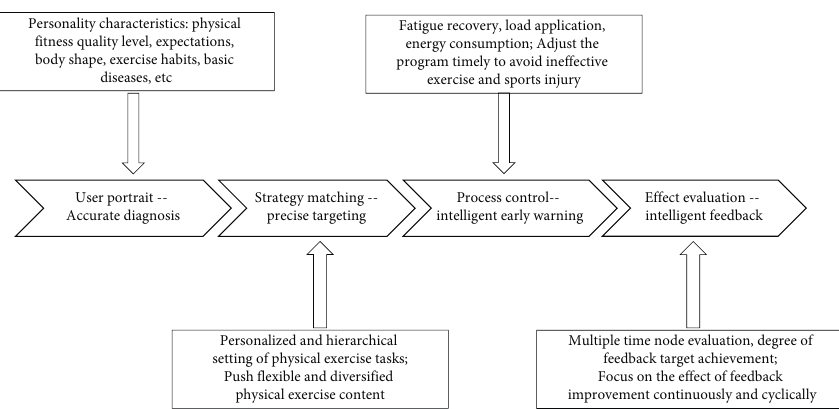
Figure 8: Progression chart of data-driven physical smart governance of college